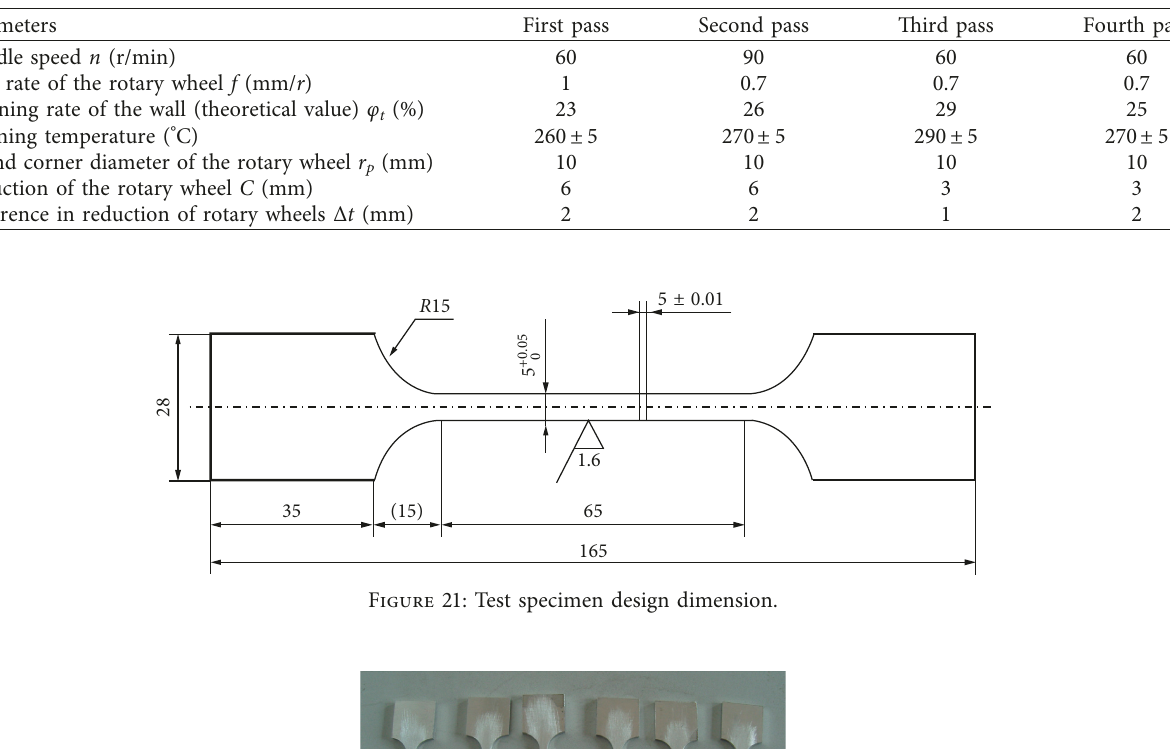
Table 6: Final process parameters.